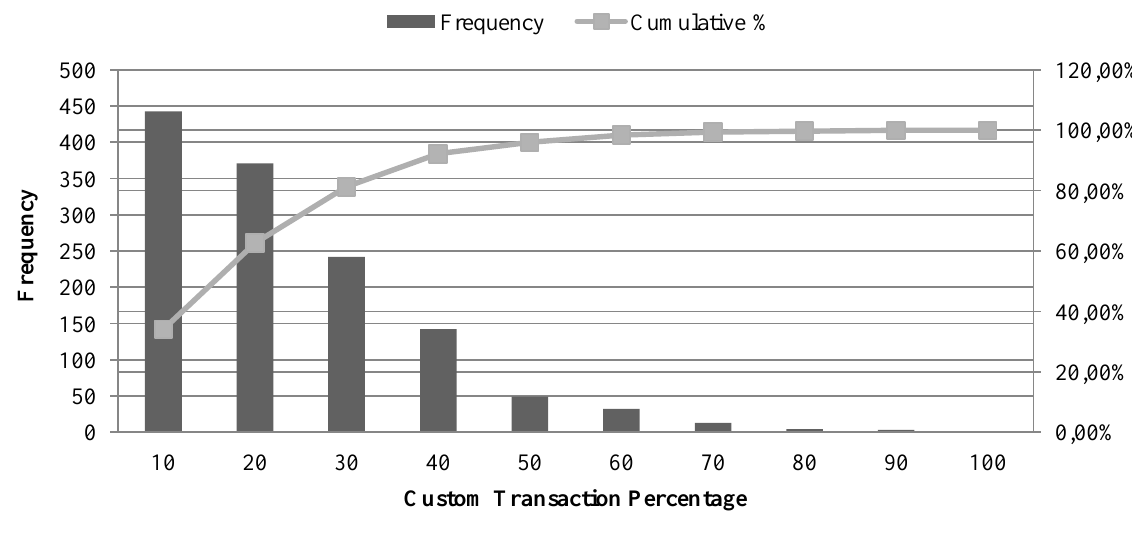
Figure 1. Usage degree of custom transactions for an enterprise standard